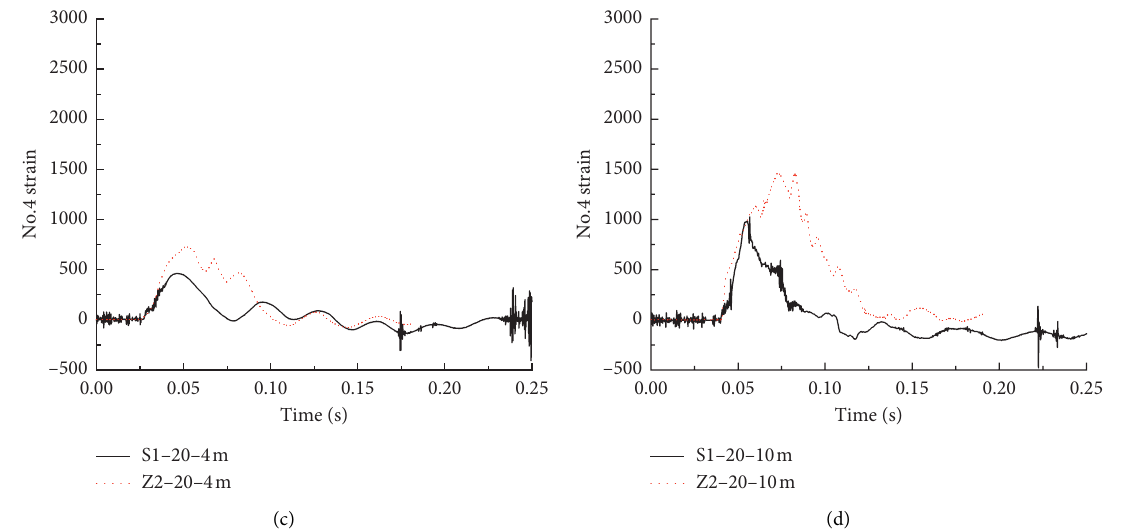
Figure 15: Time history curves of the strain of the No. 4 drop hammer when lifted to 6 m and 10m. In the figure, diameter 16 is 50mm closed-cell aluminum foam and diameter 20 is 100mm closed-cell aluminum foam. Table 8: Test results of the peak strain and stress of the No. 4 reinforcement.